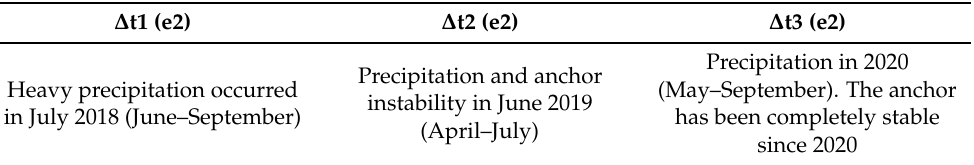
Table 1. Time increments related to the cumulative precipitation, borehole inclinometer, ground- anchor inefficiency, ground-anchor steady state, and InSAR mean downslope displacement data from June 2018 to September 2020 in the western channel of the Kawai landslide (e2 area). ∆ t1 (e2) ∆ t2 (e2) ∆ t3 (e2)